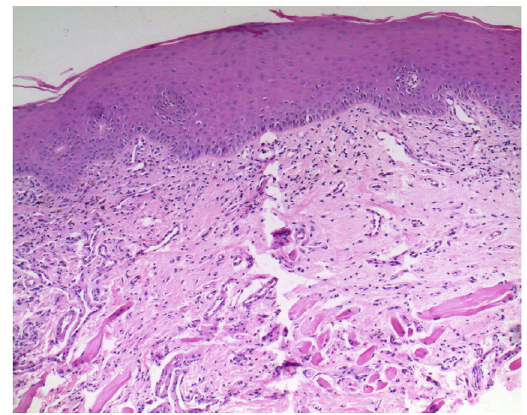
Figure 7. Histopathological picture of biopsy from tongue dorsum with typical features of mucosal lichen planus (H & E,